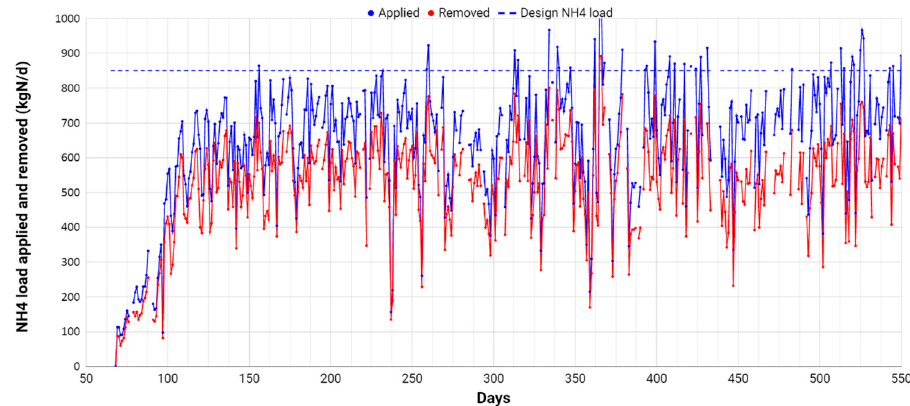
Figure 12. NH 4 load applied and removed (kgN/d) at the ANITA Mox in FiveFords.